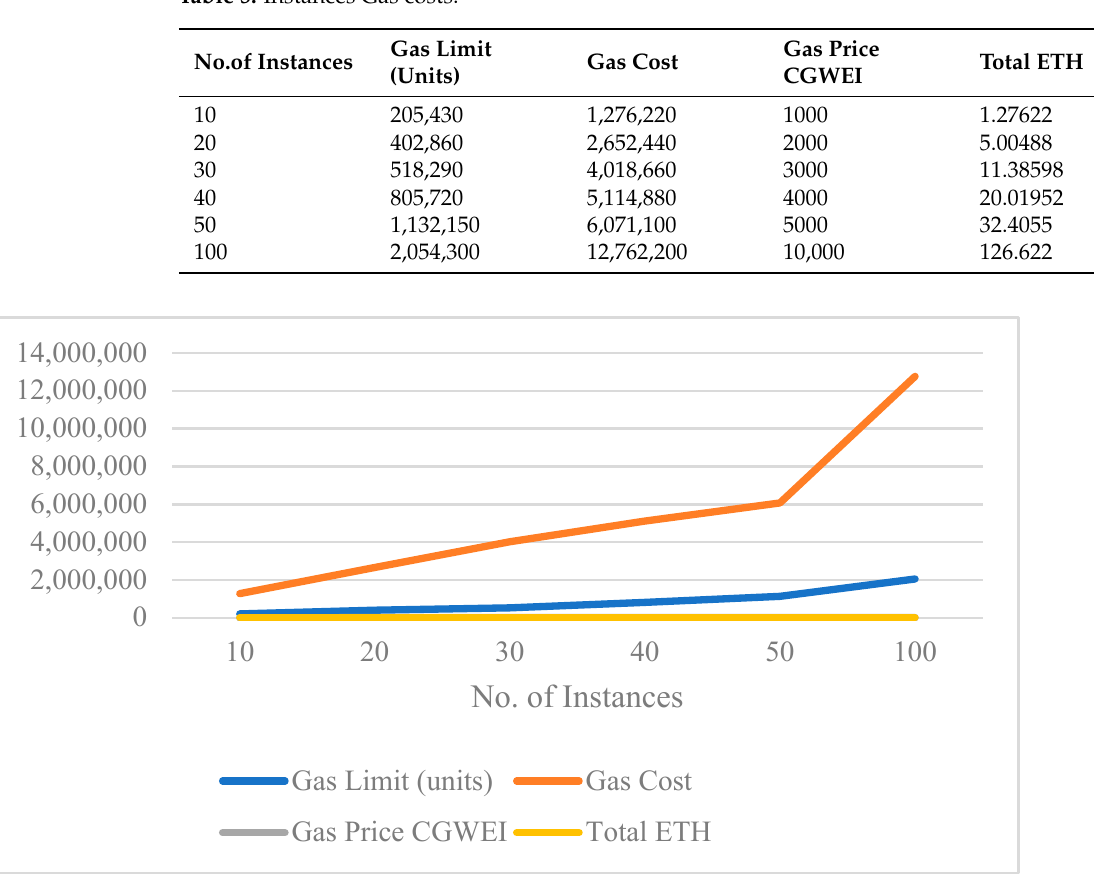
Figure 6. Consumption of